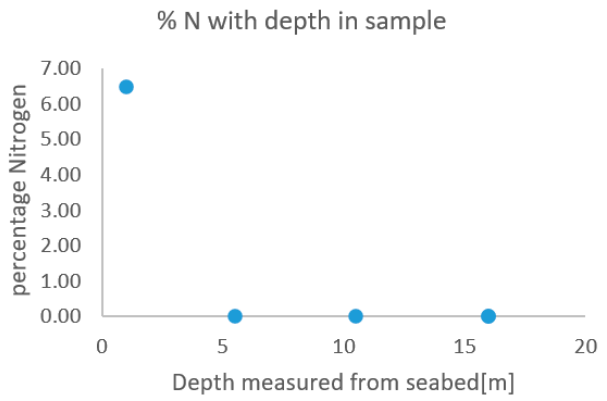
Figure 19. Variation of nitrogen content (%) (in the rust samples colour coded plates) as a function of sea depth).